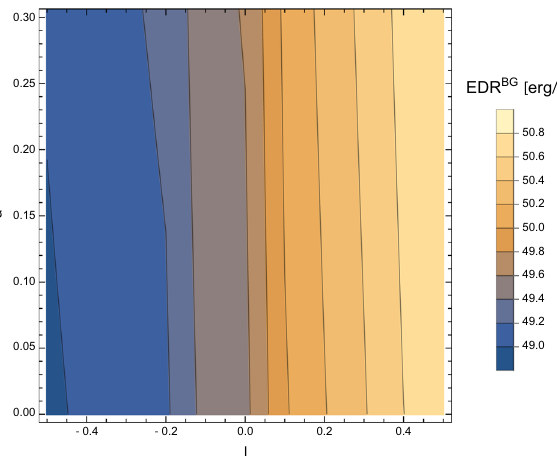
Fig. 4 The same contour plot 2 with the color scale written in the logarithmic form log10 n (the range of n is from values lesser than 49 to beyond 50), this time for the temperature gradient disk